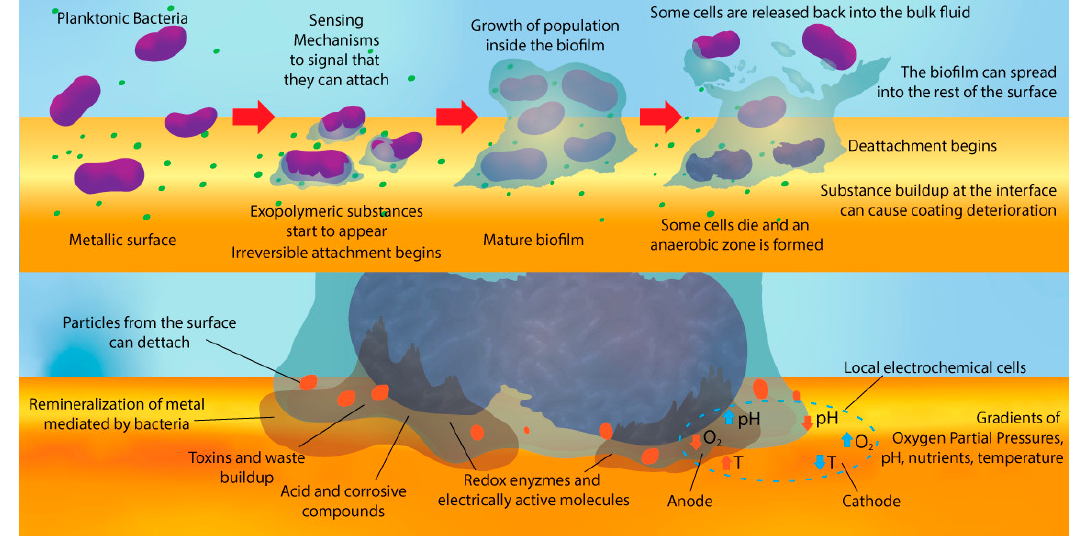
Figure 1. Schematic diagram of microbial induced corrosion and bioleaching process showing the stages of biofilm growth (upper panel) and the mechanisms involved in metal corrosion and dissolution (lower panel).